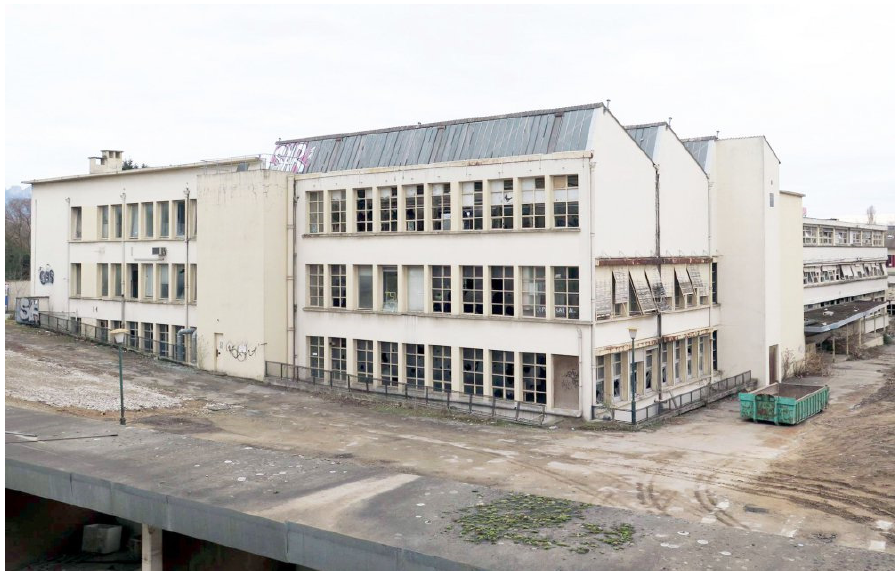
Figure 5. Wasteland of the Jourdan company in Romans-sur-Isère city center (source: 1083).